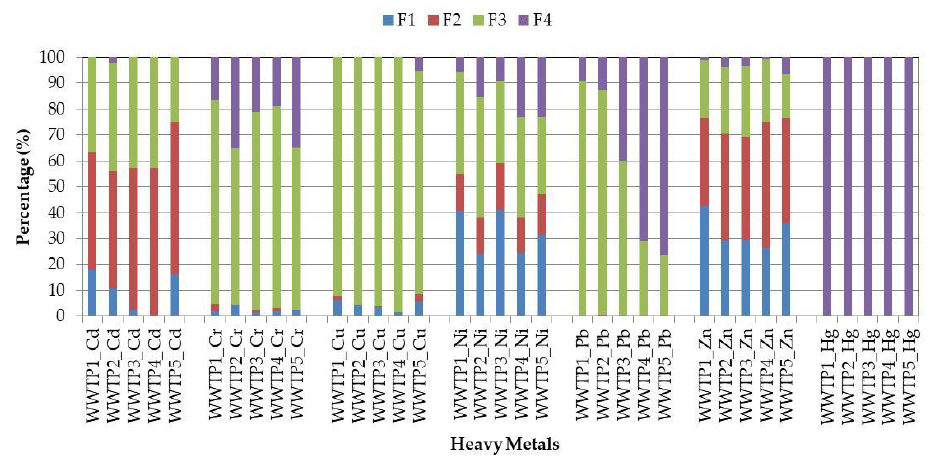
Figure 2. The average percentage distribution of each heavy metal fraction in the thickened sludge samples (S1).